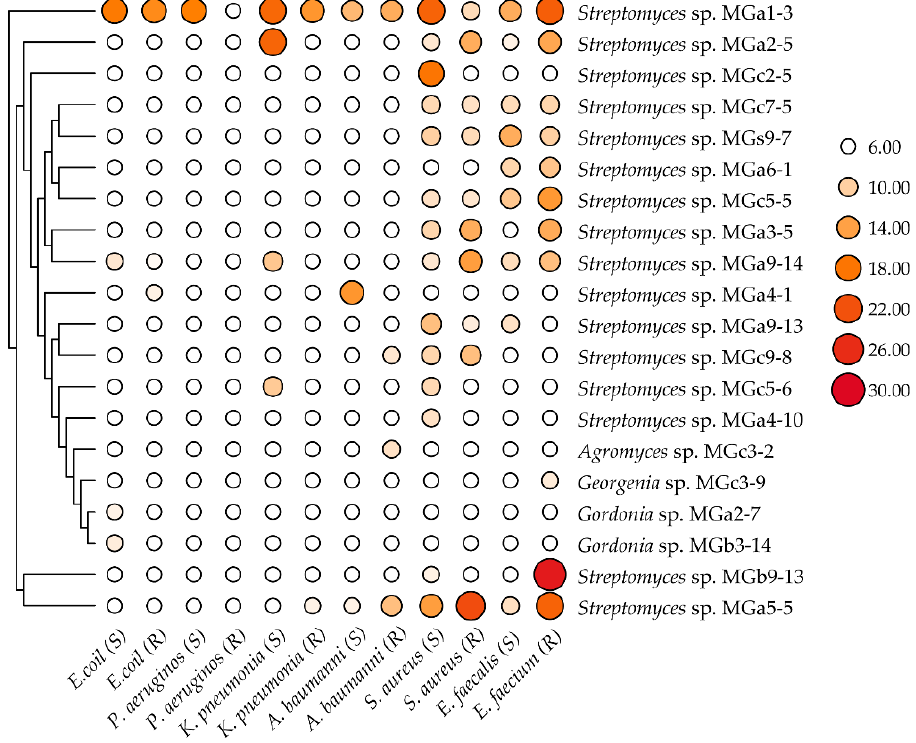
Figure 3. Antibacterial activity of bioactive ethyl acetate extracts from cultural broth of 20 strains. Numbers alongside the circles represent the diameter (mm) of the inhibition halos. 6.00 mm, no inhibitory activity; S, drug-sensitive; R, drug-resistant.